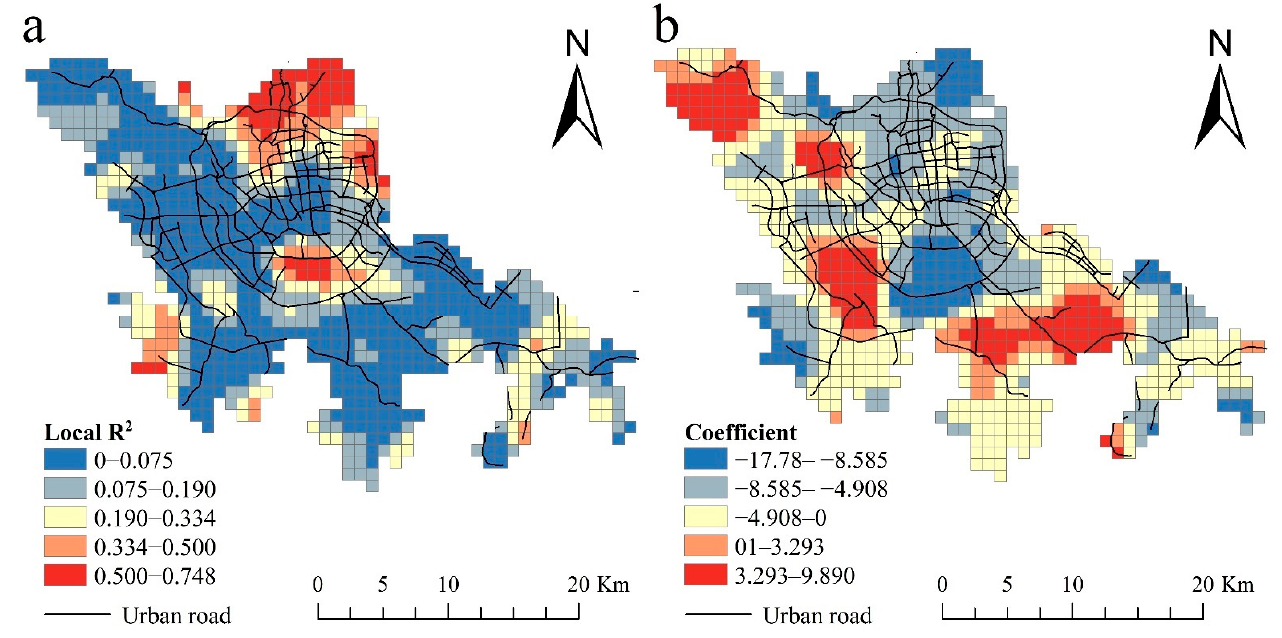
Figure 9. Local R 2 and coefficient of GWR model. (a) is the local R 2 of GWR model; (b) is the coeffi- cient of GWR